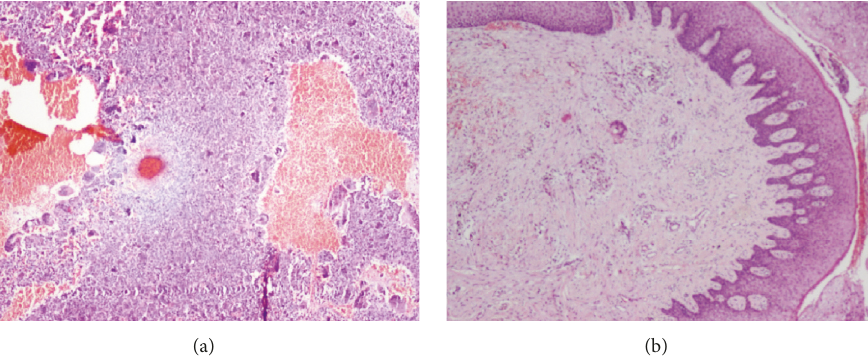
Figure 3: Microscopically the lesion is composed of blood-filled spaces separated by connective tissue septa containing fibroblasts, osteoclast- type giant cells.